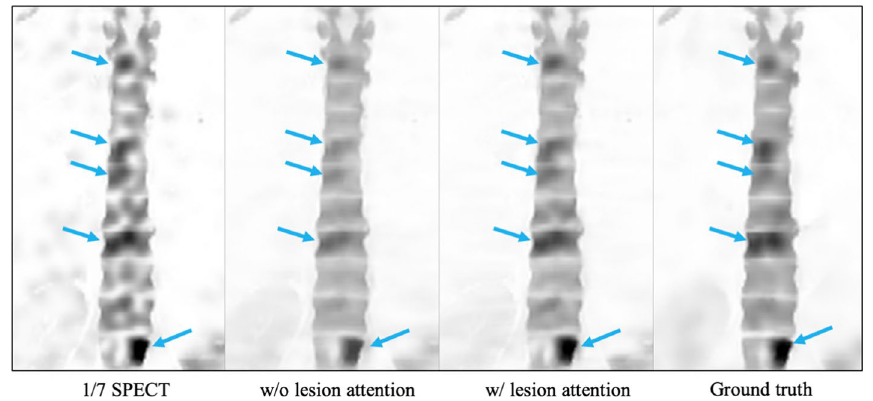
Fig. 9 Visual results of w/ and w/o lesion attention as input of the proposed model. Enhanced image with lesion attention loss holds clearer SUV variation within tissues than those without lesion